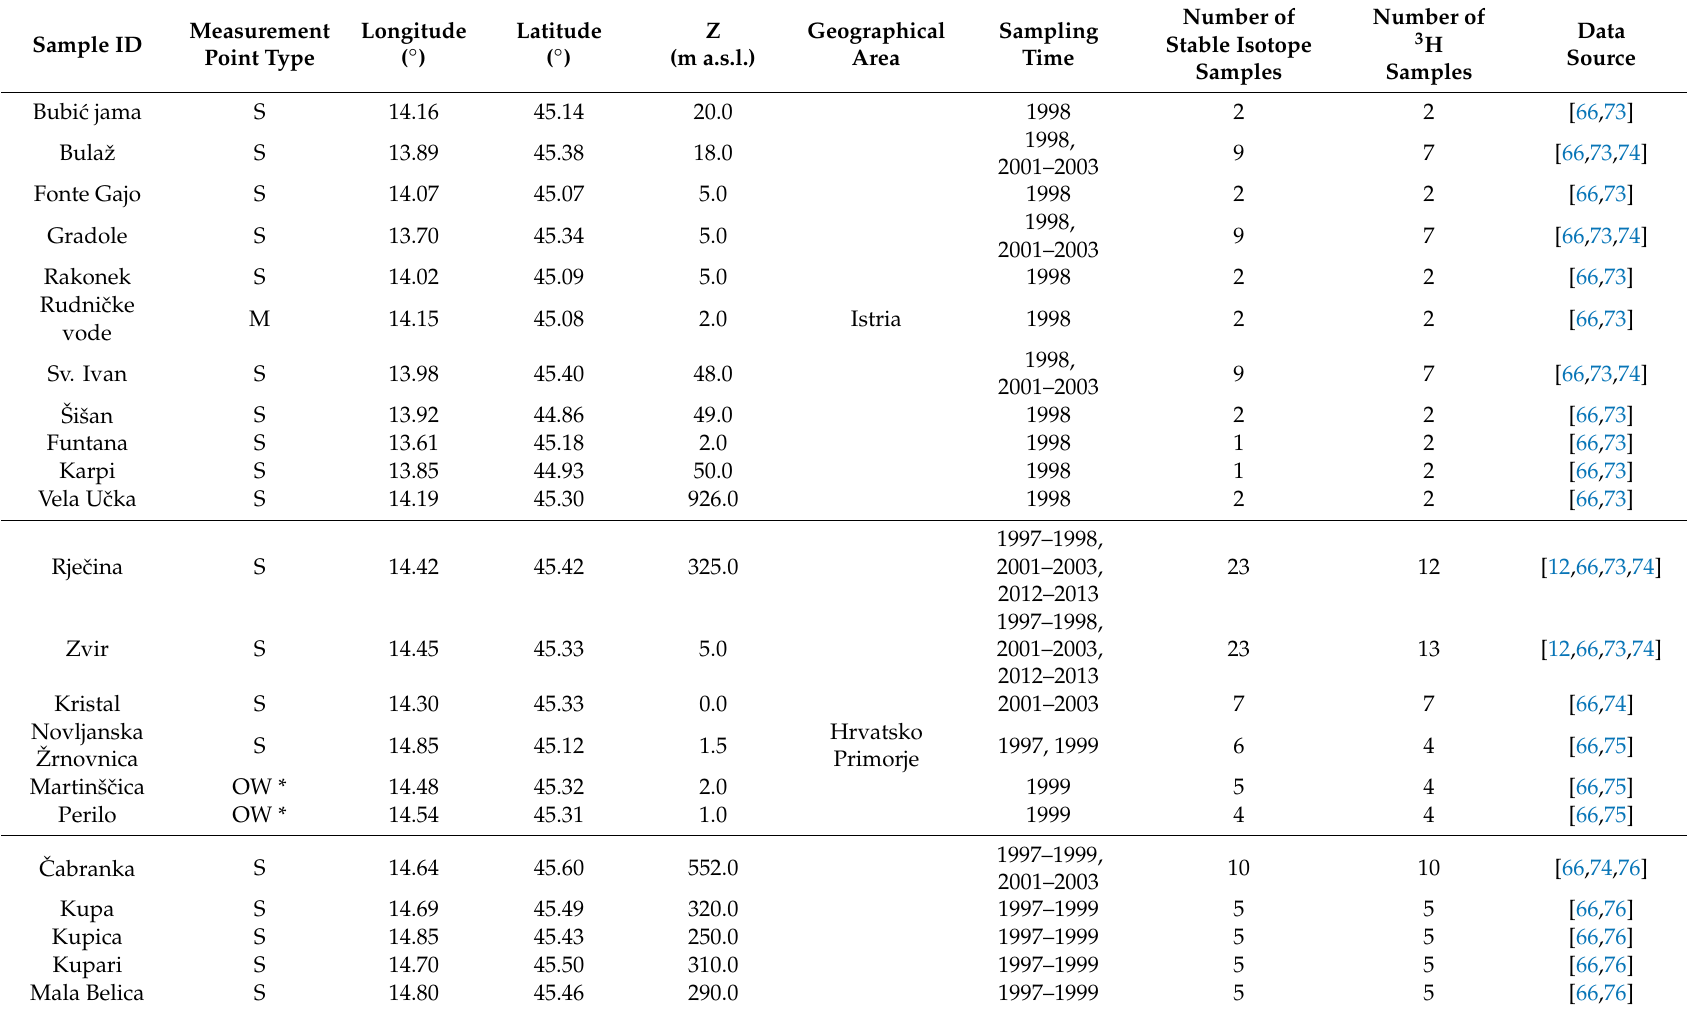
Table 2. Information on the measurement points in the karst part of Croatia. Legend: measurement point type (OW—observation well, S—spring,